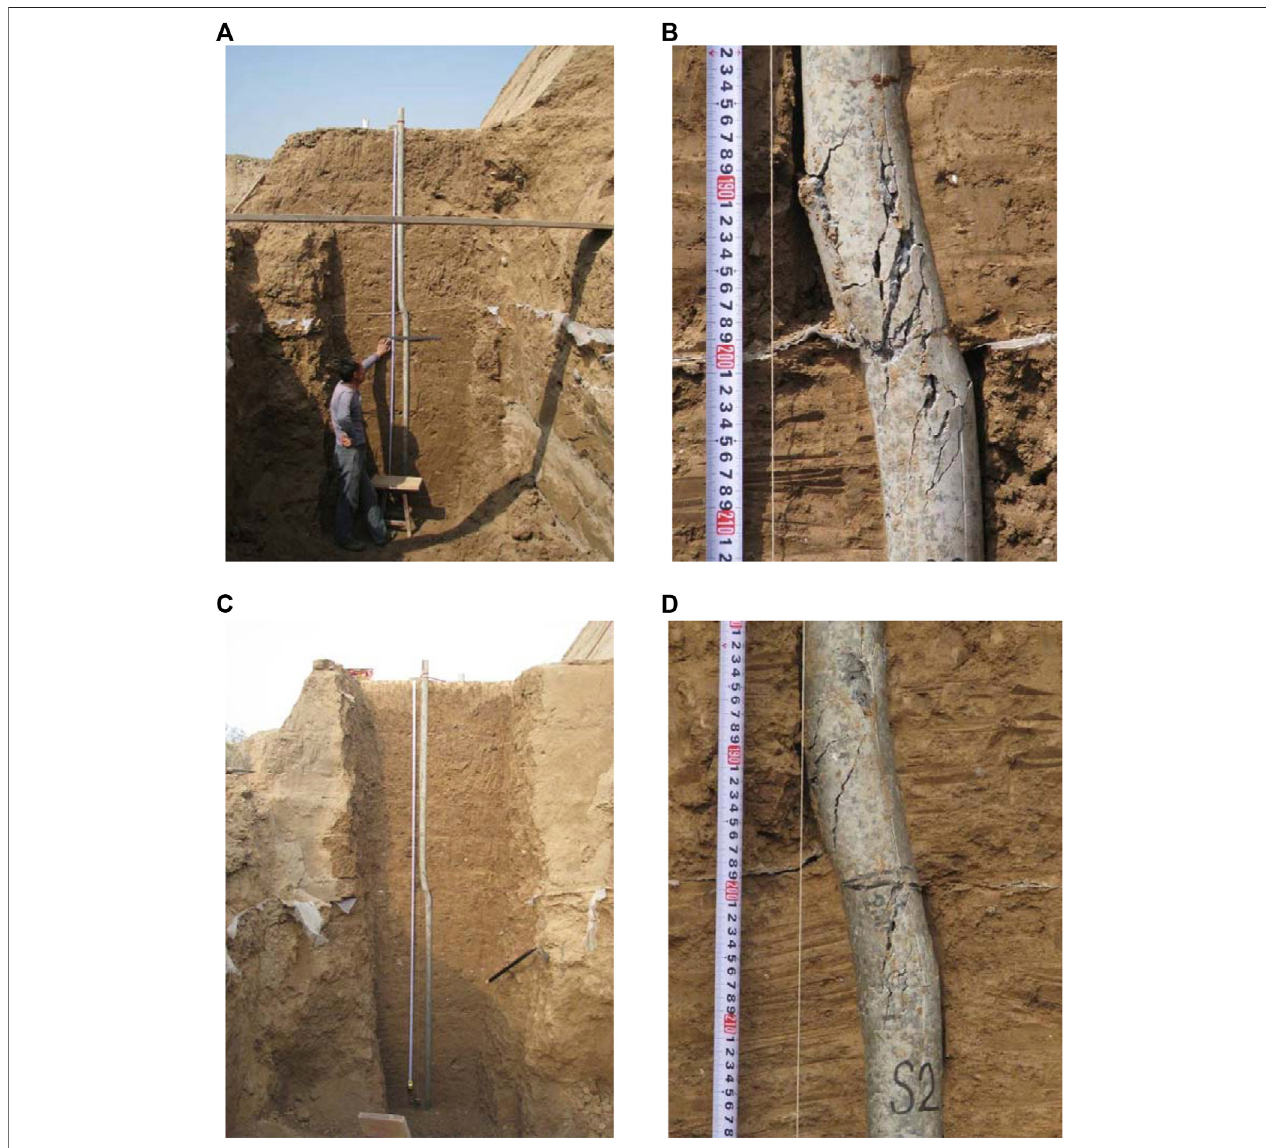
FIGURE6| Thedamageofpilesindouble-rowcon fi guration: (A) overalldamageofthepilesinthefrontrow, (B) breakageofthepileneartheslippingsurfaceinthe front row, (C) overall damage of the piles in the rear row, and (D) breakage of the pile near the slipping surface in the rear row.